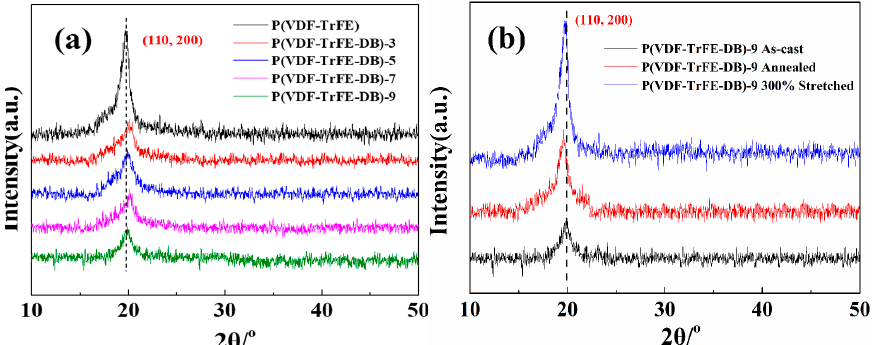
Figure 4. XRD spectra of the as-cast P(VDF-TrFE) (80/20 mol %) and P(VDF-TrFE-DB)s with different composition ( a ), and P(VDF-TrFE-DB)-9 with different treatment conditions ( b ).